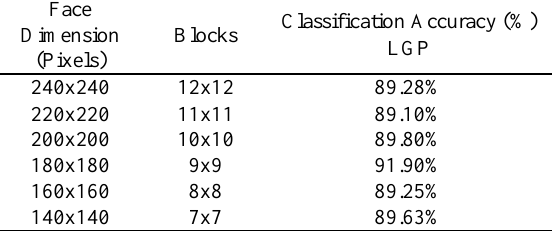
Table 3. Face Dimension vs. Classification